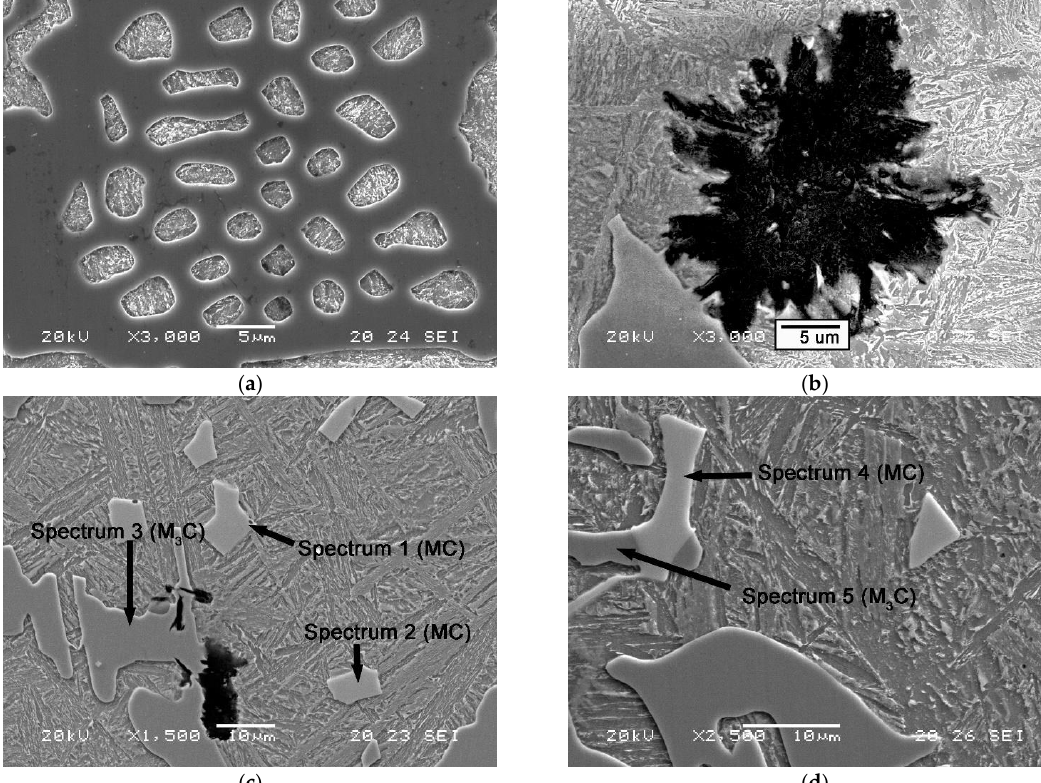
Figure 4. Main phases and constituents. ( a ) Experiment 2 in zone I, ledeburite; ( b ) experiment 3 in zone III, graphite; ( c ) experiment 3 in zone I, carbides; ( d ) experiment 6 in zone I,